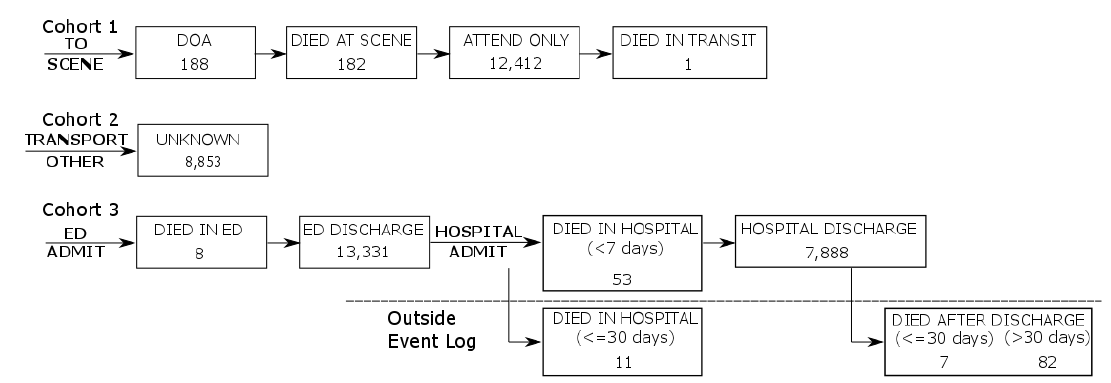
Figure 12. Model of patient outcomes by cohort. Nodes represent patient outcomes, i.e., points of exit from the process. Node numbers show the number of patients with that